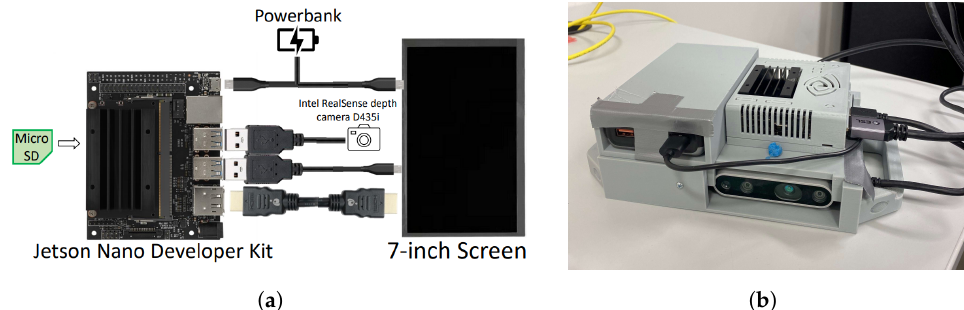
Figure 9. Complete wiring diagram and housing ( a , b ) consisting of 3D printed components, NVIDIA Jetson Nano, 5 V/2 A Power bank, Intel RealSense D435i, and a 7-inch